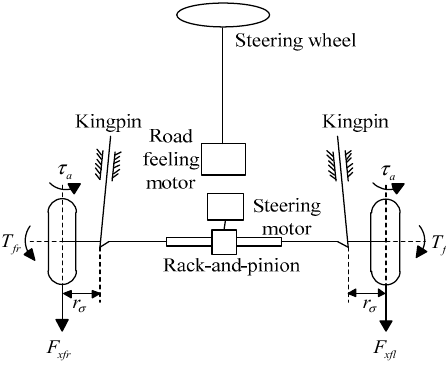
Figure 2. Differential steering system of DSV.